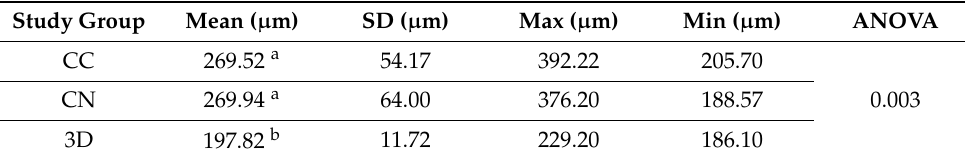
Table 1. Mean and SD for interim crown